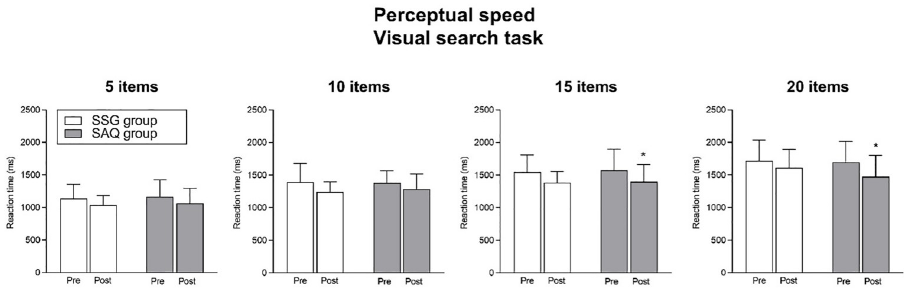
Fig 4. Effect of training intervention on perceptual speed (reaction time for 5, 10, 15 and 20 items conditions in the visual search task). Post < pre by Bonferroni post-hoc tests: � P < 0.05.